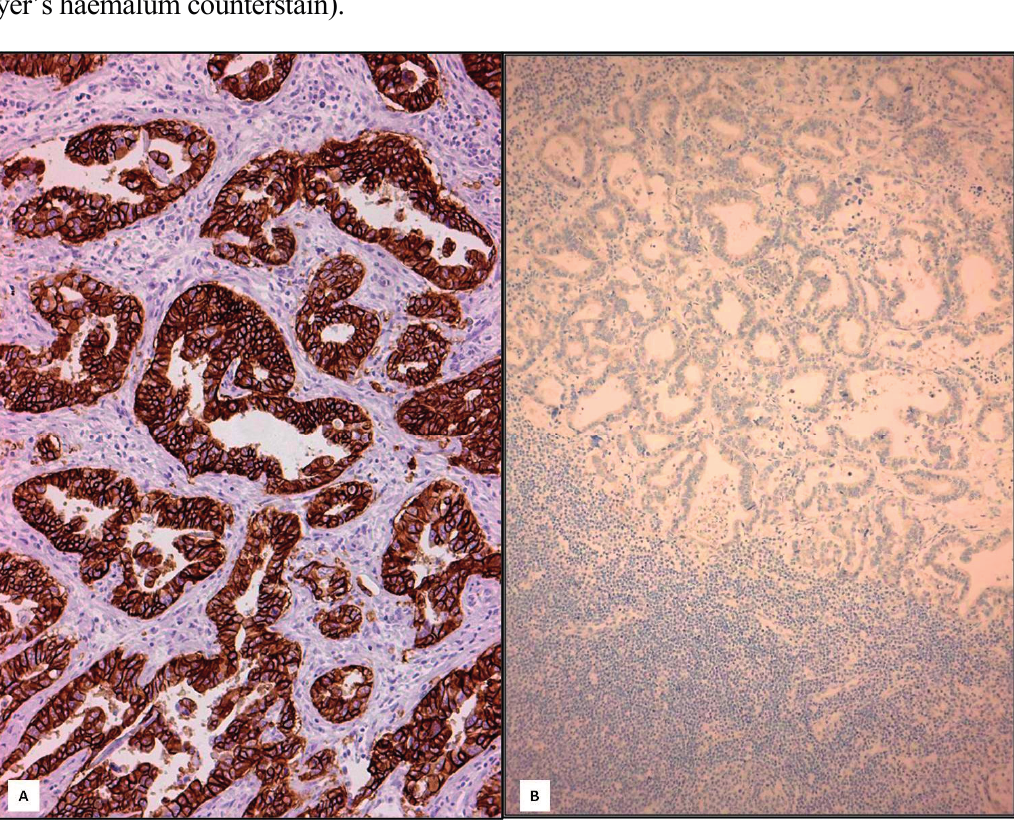
Figure 1. In intestinal type primary GC, the 3+ score present in neoplastic glands ( A , 200×) disappeared in metastatic lymph node (negative conversion) ( B , 160×) (Immunohistochemistry, Mayer’s haemalum